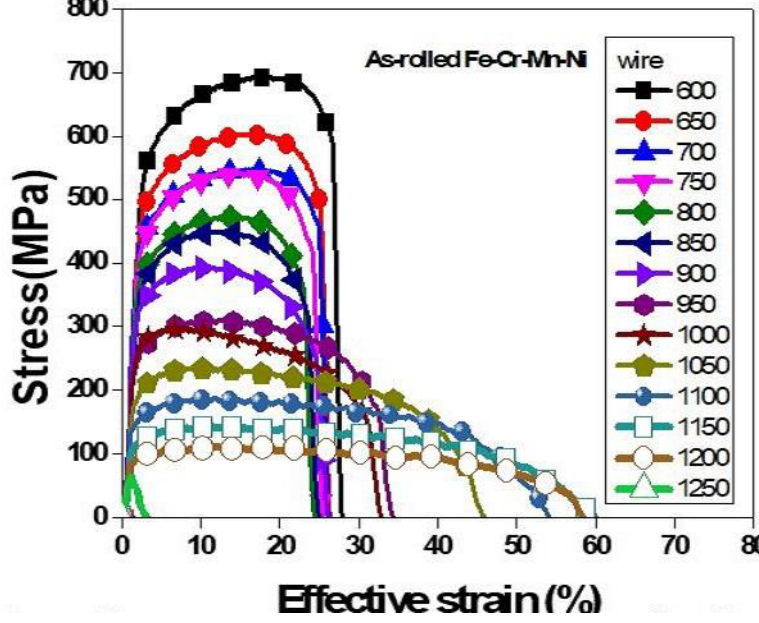
Figure 7. Effective stress-strain curves obtained using the effective strain defined in the present study.